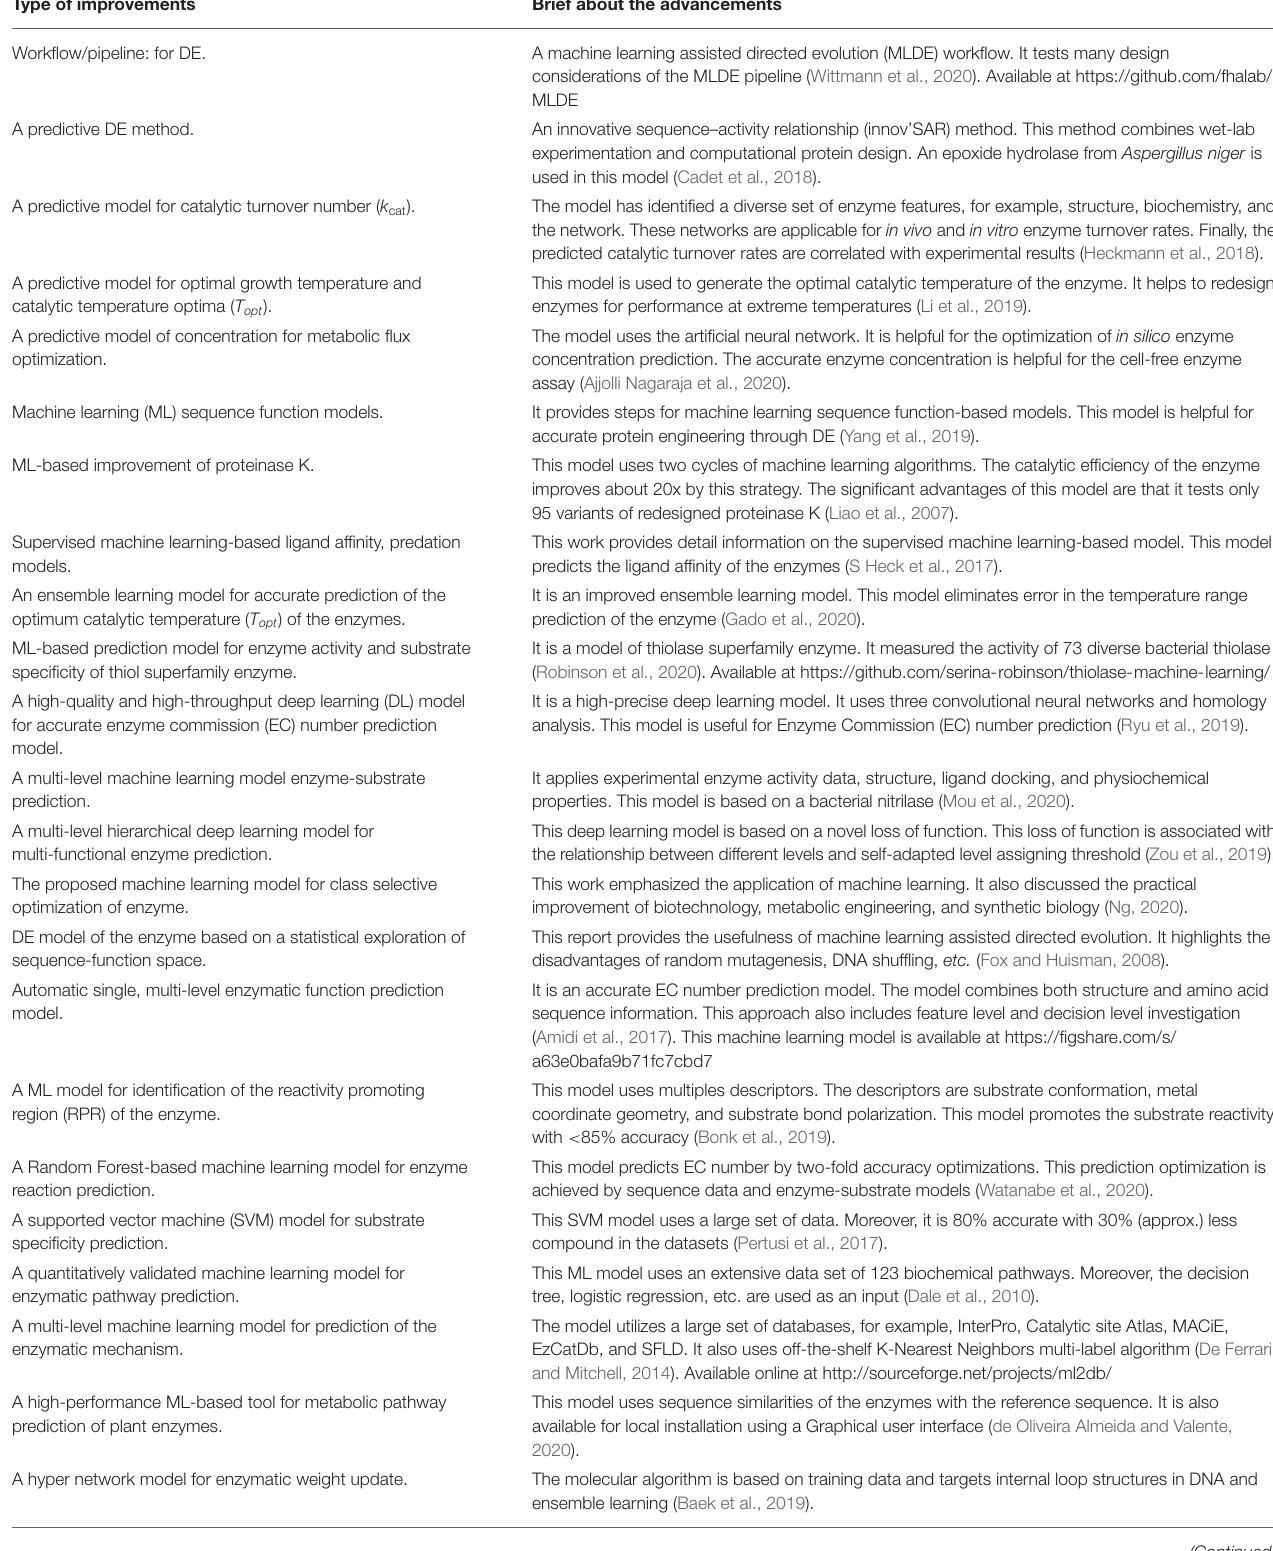
TABLE 1 | Summary of enzyme engineering approaches and new